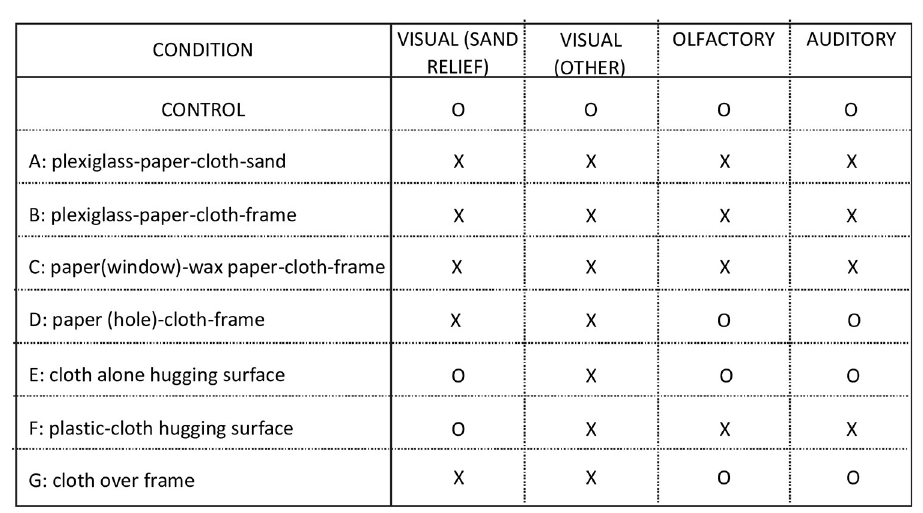
alter at least one potential homing cue that might help the wasps to precisely locate their bur- row entrances. Each cover is referred to as condition and the name of each condition begins with the part closest to the land surface, followed in upward placement order of the subsequent parts. The conditions are shown in Fig 2.